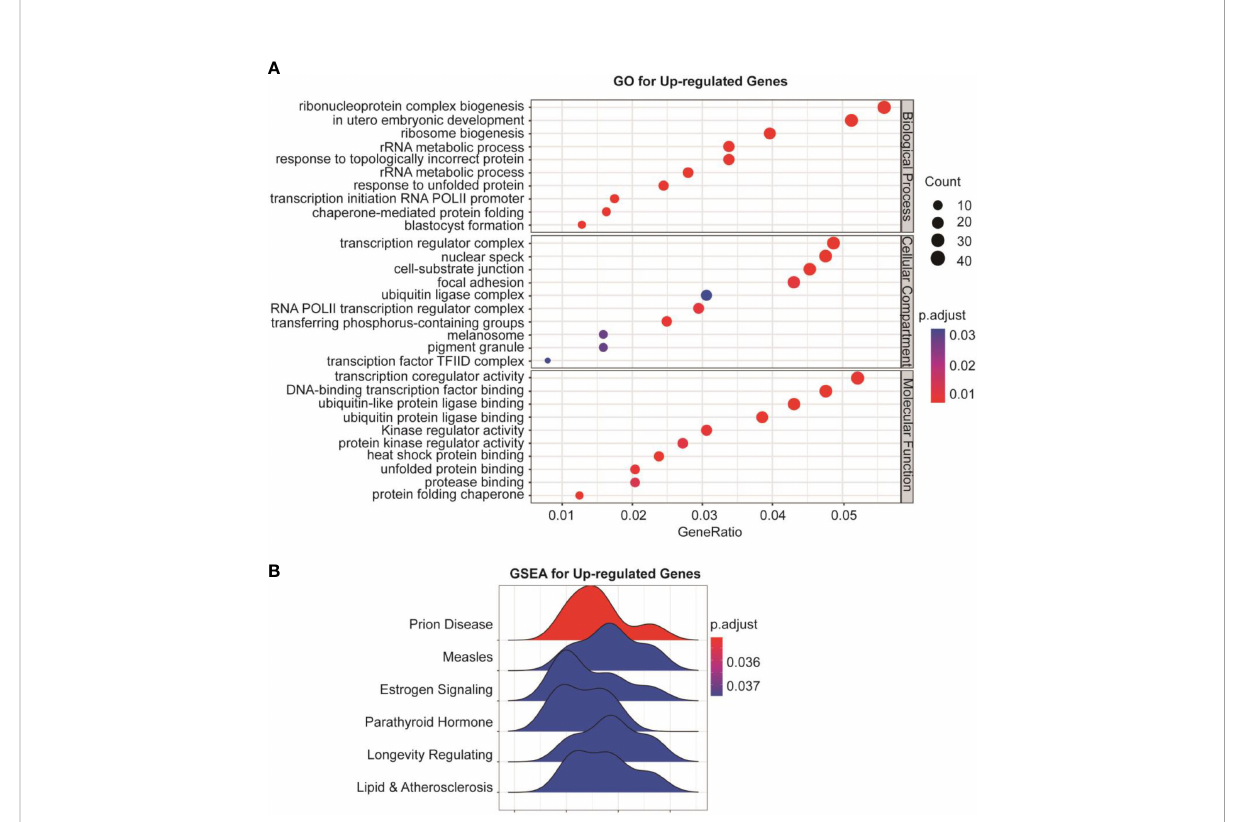
FIGURE 6 Protein degradation and unfolding are activated by GSK-J4 in DaoY cells. (A) GO analysis of the up-regulated genes in DaoY cells treated with GSK-J4. (B) GSEA analysis of the up-regulated genes in DaoY cells treated with